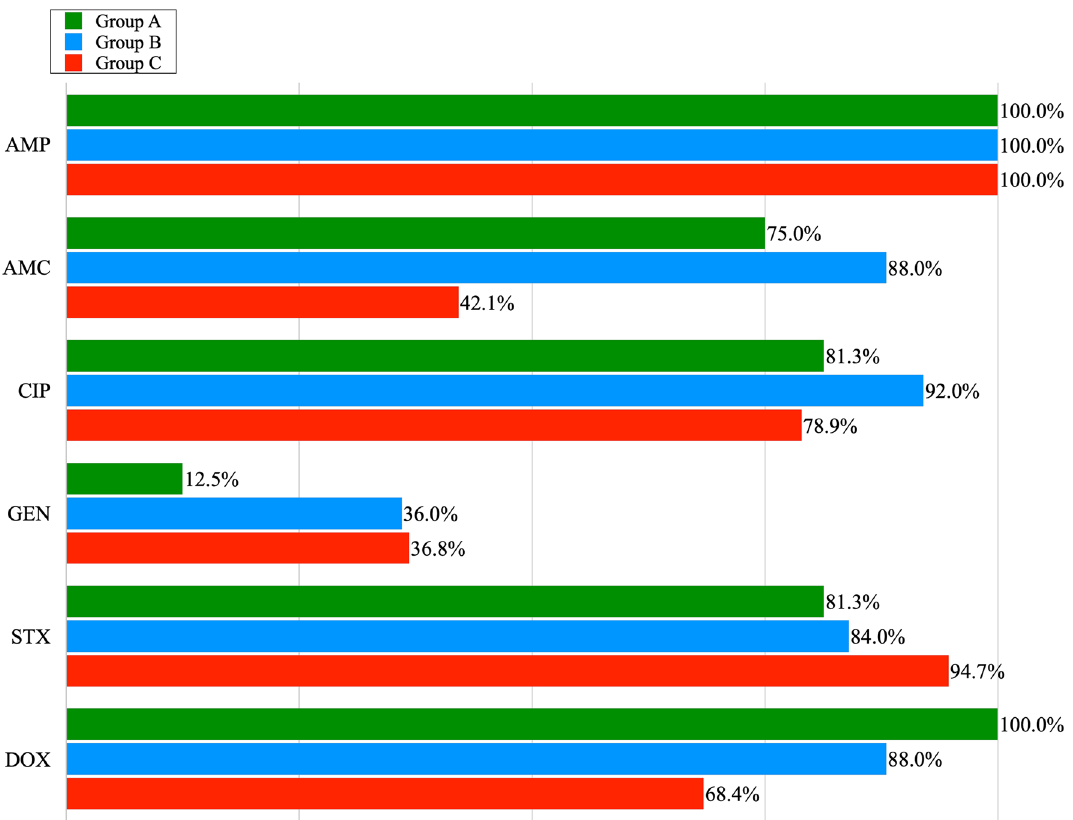
Figure 1. The percentage of phenotypic resistance to 6 antibiotics among the MDR E. coli isolates obtained from poultry litter (Group A), cloacal swabs (Group B) and poultry meat (Group C): AMP—Ampicillin;